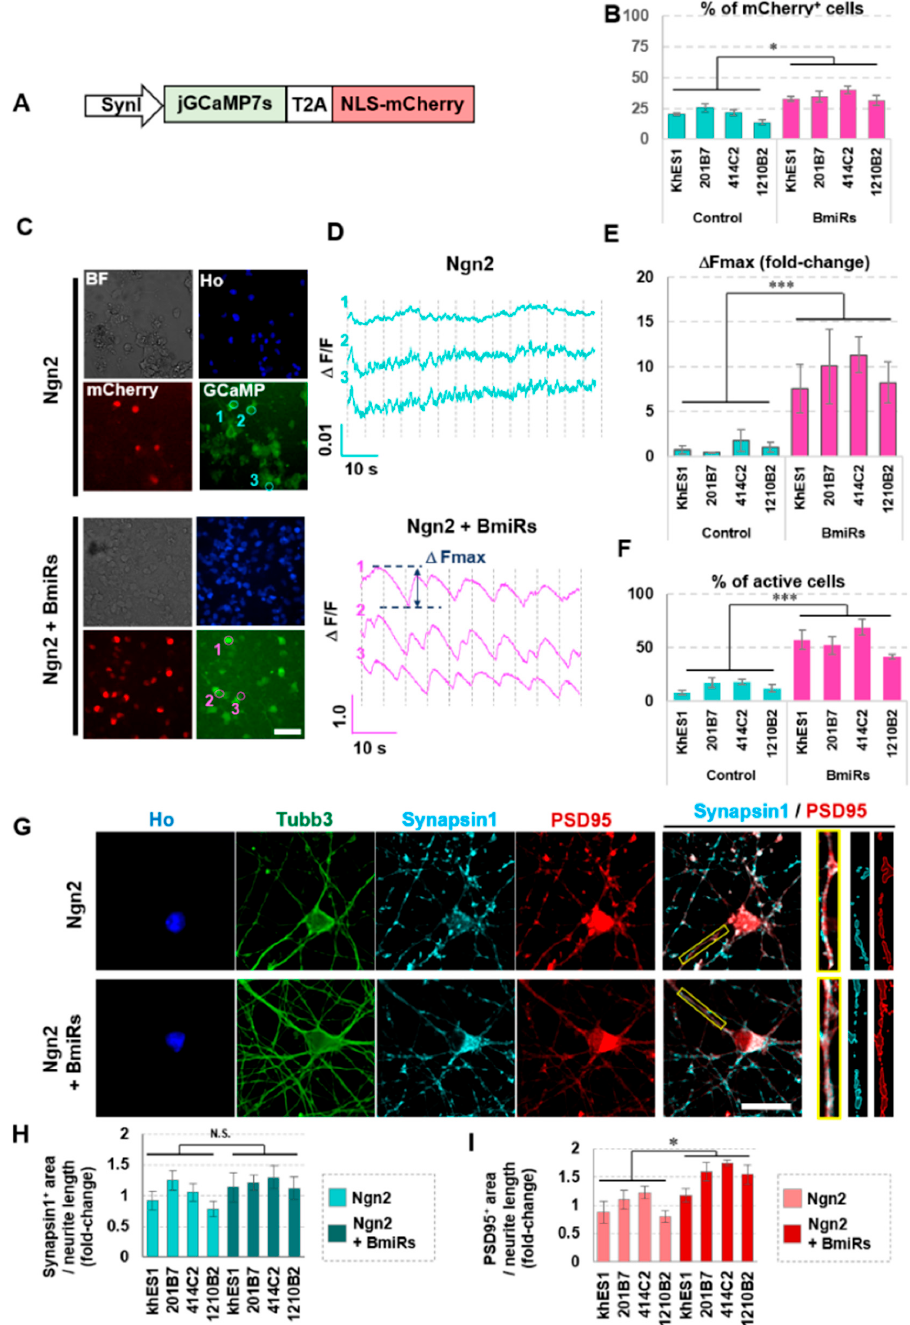
Figure 4. Evaluation of neuronal functionality using GCaMP and quantification of synapse-related proteins. ( A ) Design of the lentiviral vector for Synapsin1::jGCaMP7s-T2A-NLS -mCherry. ( B ) Ratio of positive cells for Synapsin1::mCherry + cells in live cells. The number of total cells was defined as the total number of Ho signal. (n = 4 independent experiments; mean ± SEM; * p < 0.05, Dunnett’s test). ( C ) Representative GCaMP7s and mCherry images. The circled ROIs are depicted in ( D ) as time- dependent changes in GFP fluorescence intensity. Scale bar: 50 µm. ( D ) Representative images of GCaMP spikes and display of parameters ( Δ Fmax). ( E ) Comparison of Δ Fmax values. The average